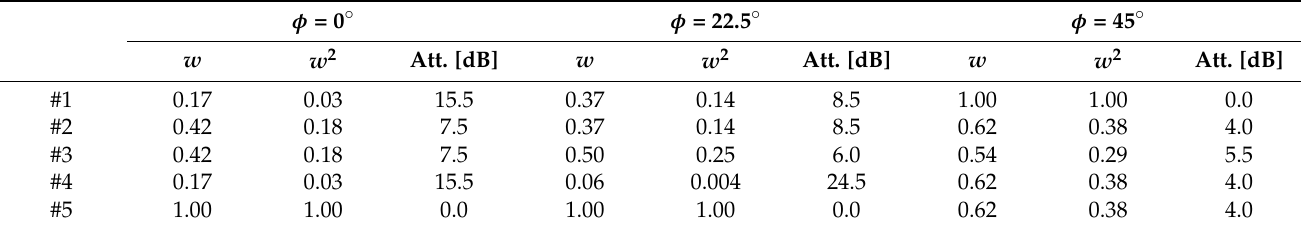
Table 2. Setup of the